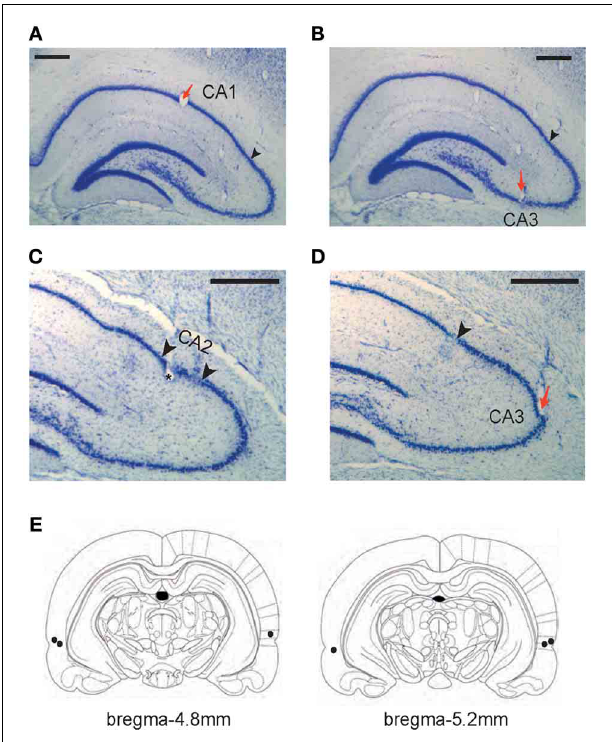
FIGURE 2 | Histological verification of recording and drug-injection locations. (A–D) Representative tetrode locations for CA1 (A) , CA3 ( B and D) , and CA2 (C) . The tetrodes whose final recording positions were identified in CA2 were not included in final analyses. Red arrows indicate tetrode-tip locations and black arrowheads in A, B, and D denote the proximal end of CA1 layer (CA1-CA2 border). Two arrowheads in C mark putative CA2 boundaries ( ∼ 300 μ m from the CA1-CA2 boundary). Scale bars = 500 μ m. (E) Illustration of the injection cannula-tip positions (black dots) in PER for three rats. Each section’s longitudinal position in reference to brema is